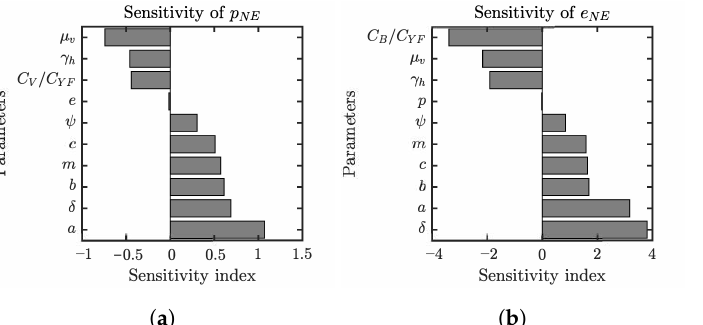
Figure 6. Summaries of the sensitivity analysis of ( a ) p NE and ( b ) e NE based on [46]. Only parameters for which the absolute value of the sensitivity index is greater than 0.005 are shown. The sensitivity index of p NE on a parameters x calculated as 1% increase in a parameter value x will result in a 0.5% decrease in p NE . The values of parameters that are not varied are as specified in Table